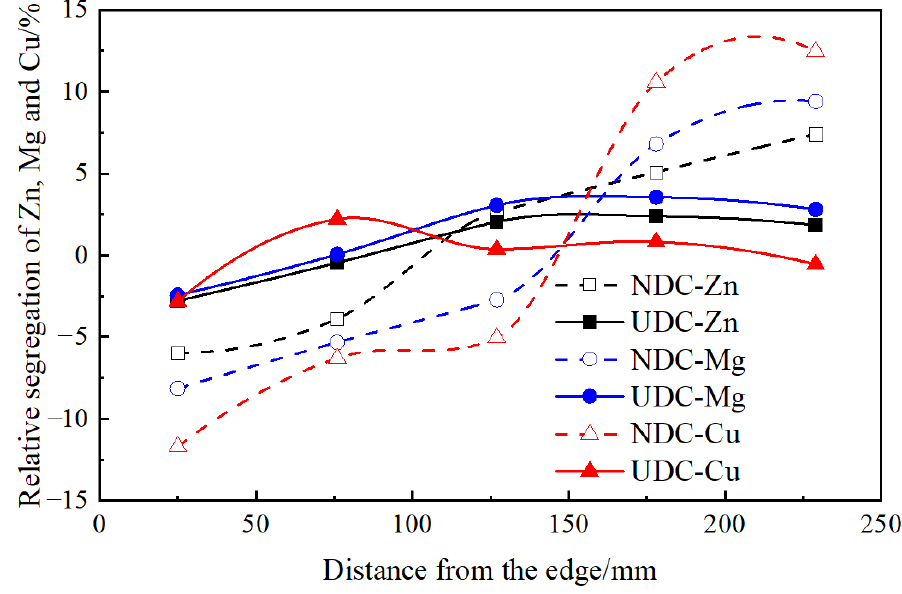
Figure 4. Zn, Mg and Cu elements distribution along radical direction of Φ508 mm Al–Zn–Mg–Cu alloy billets prepared by NDC casing and UDC casting.